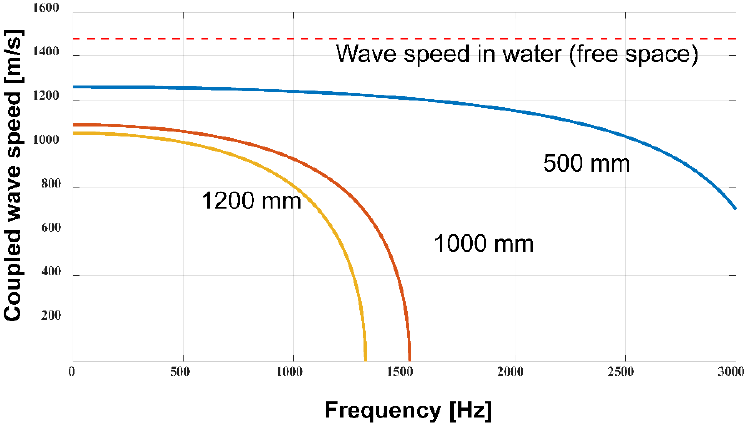
Figure 1. Dispersion curve for water-pipe coupled wave speeds for steel pipes with different diameters. Table 1. Material properties and geometric dimensions for dispersion